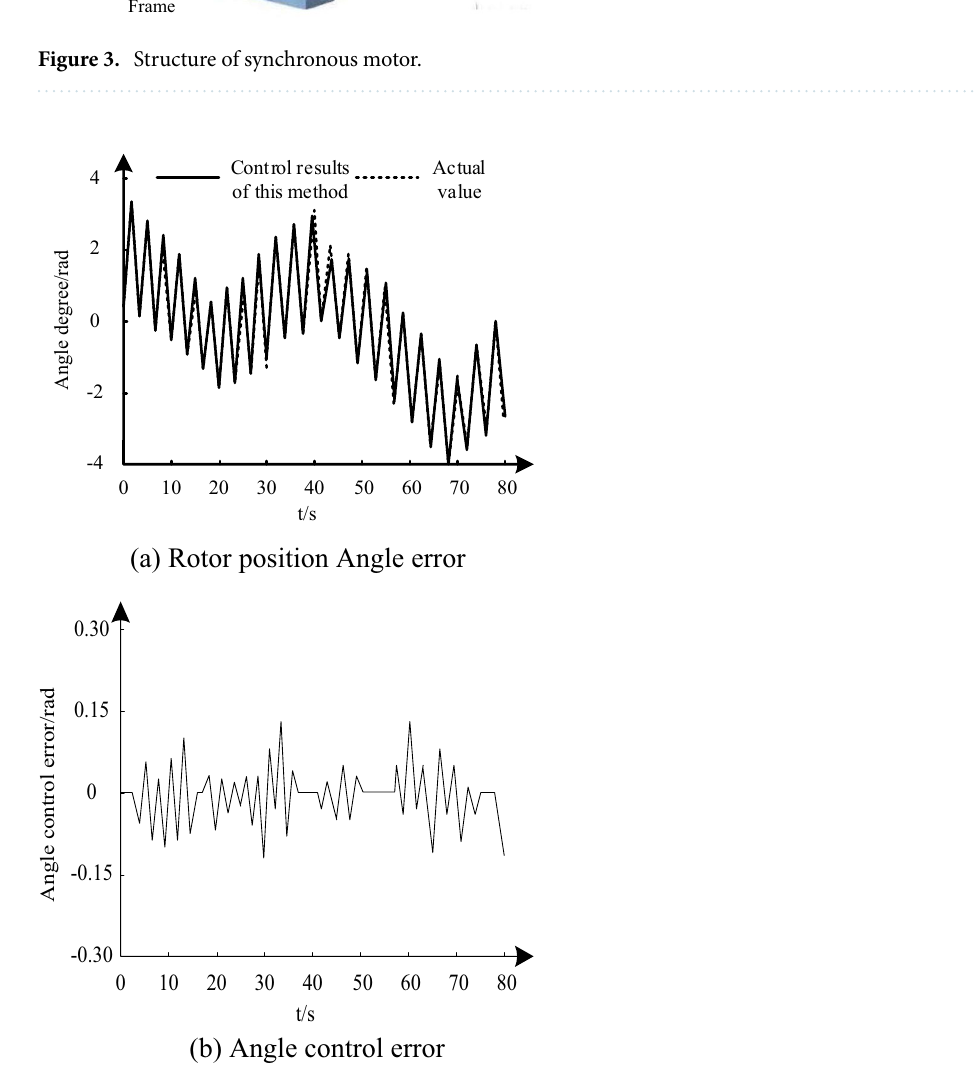
Figure 4. Control results of this method. ( a ) Rotor position Angle error. ( b ) Angle control